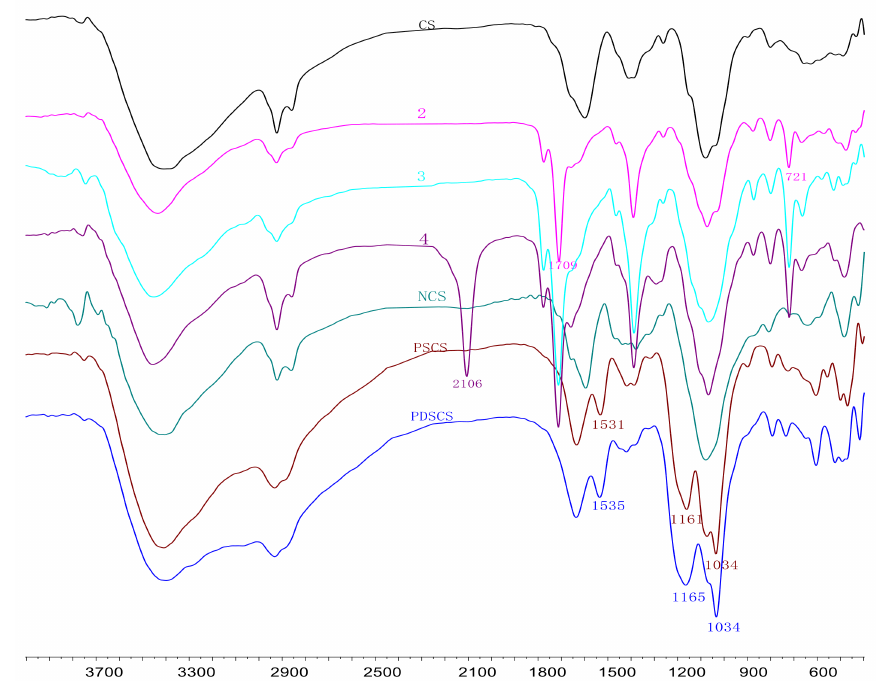
Figure 1. IR spectra of the chitosan (CS), phthaloylation of chitosan (intermediate 2 ), 6-bromo-6-deoxy- N -phthaloyl-chitosan (intermediate 3 ), 6-azido-6-deoxy- N -phthaloyl-chitosan (intermediate 4 ), 6-amino-6-deoxychitosan (NCS), propane sulfonated chitosan (PSCS), and dipropane sulfonated chitosan